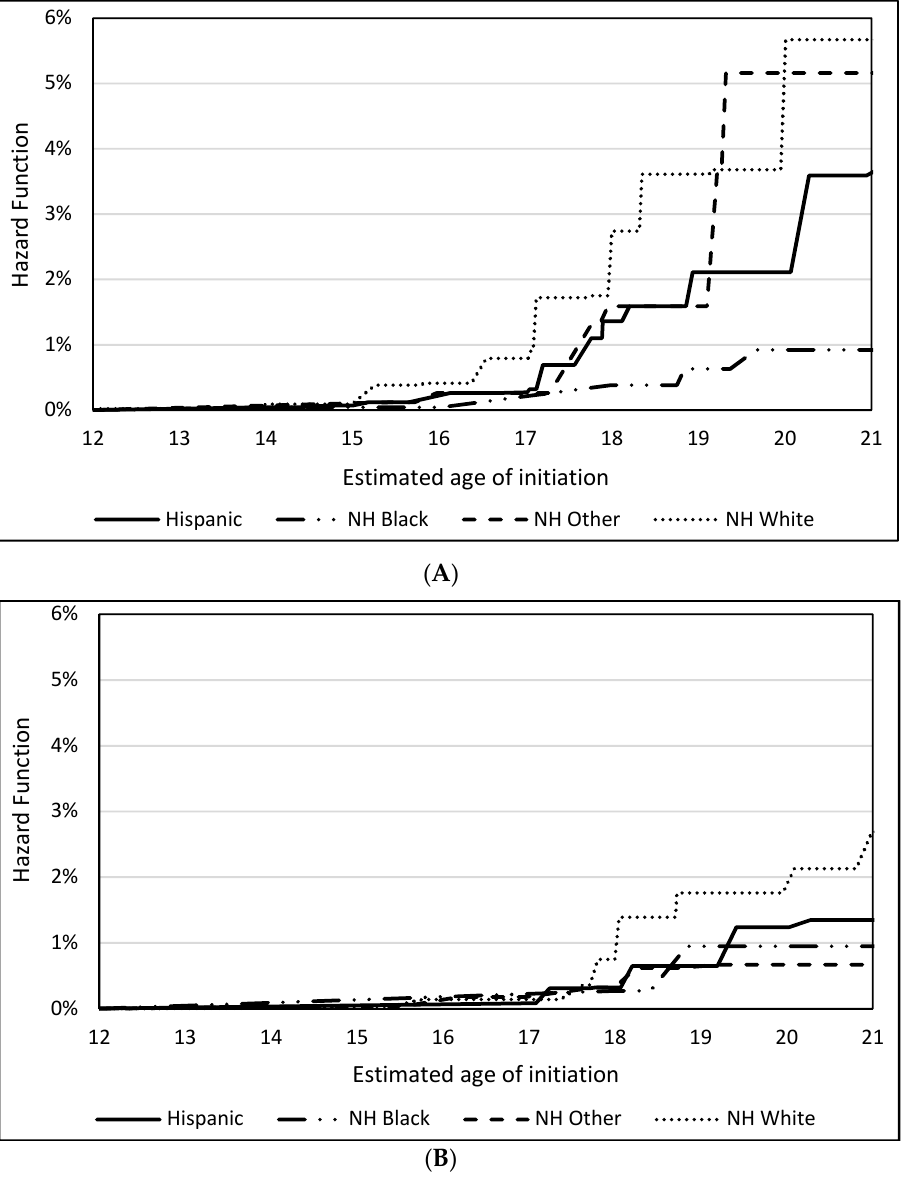
Figure 1. Hazard functions of the age of initiation of past 30-day use of ( A ) cigarettes, e-cigarettes, and binge drinking and past 30-day use of ( B ) cigarettes, cigarillos, and binge drinking by race/eth- nicity.